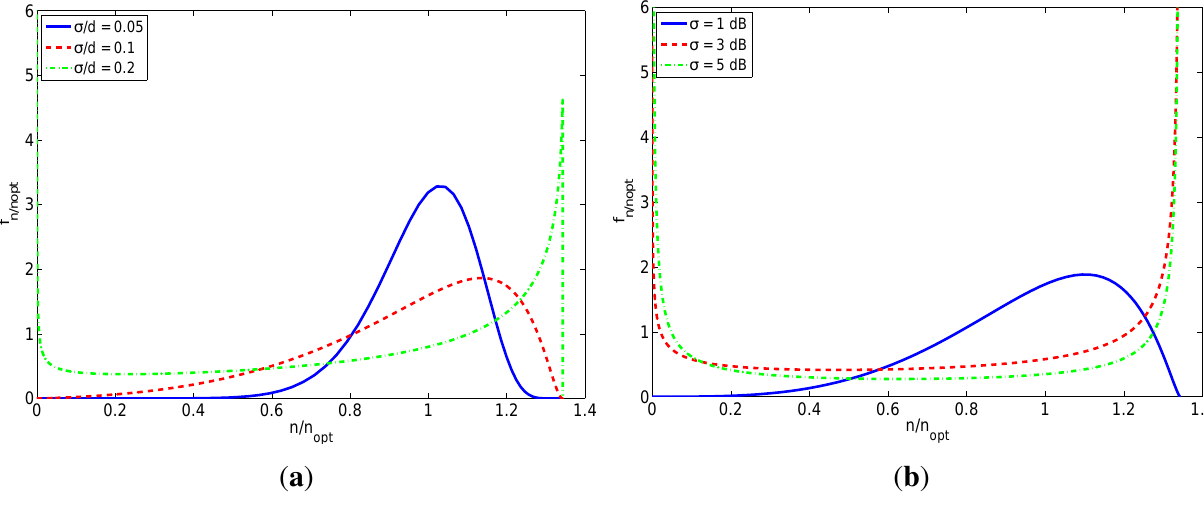
Figure 6. Probability density function of n/n schemes. ( a ) TOA; ( b )